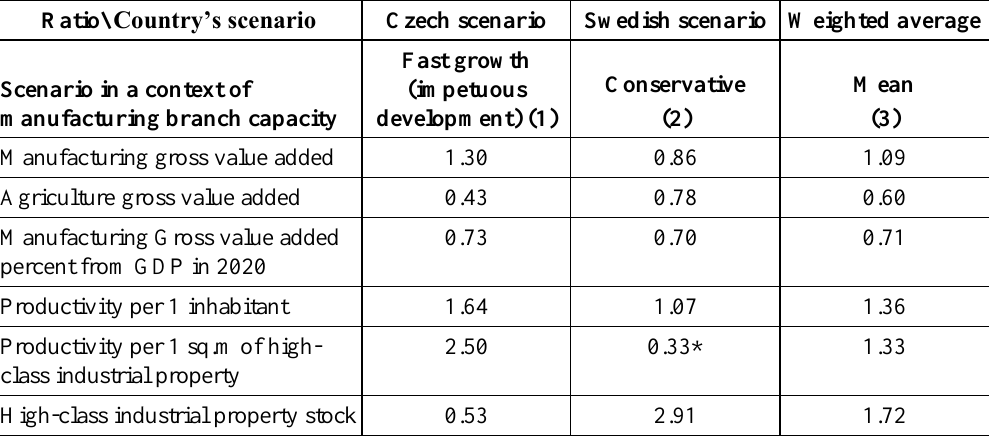
Table 3. Coefficient summary of the Latvian forecasted research data comparison to 2009 official data [calculations and presentation made by